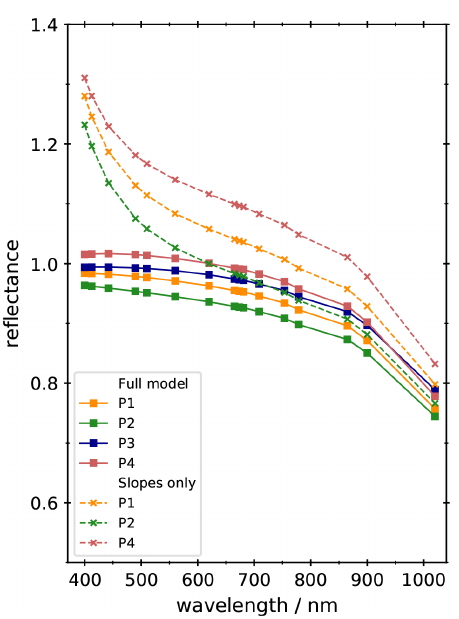
Figure 11. Reflectance spectra simulated for 4 pixels (P1, P2, P3, and P4) across the study site on 13 February 2018 using REDRESS (solid lines) and REDRESS slope (dashed lines). The spectrum sim- ulated for P3 with REDRESS slope is not shown